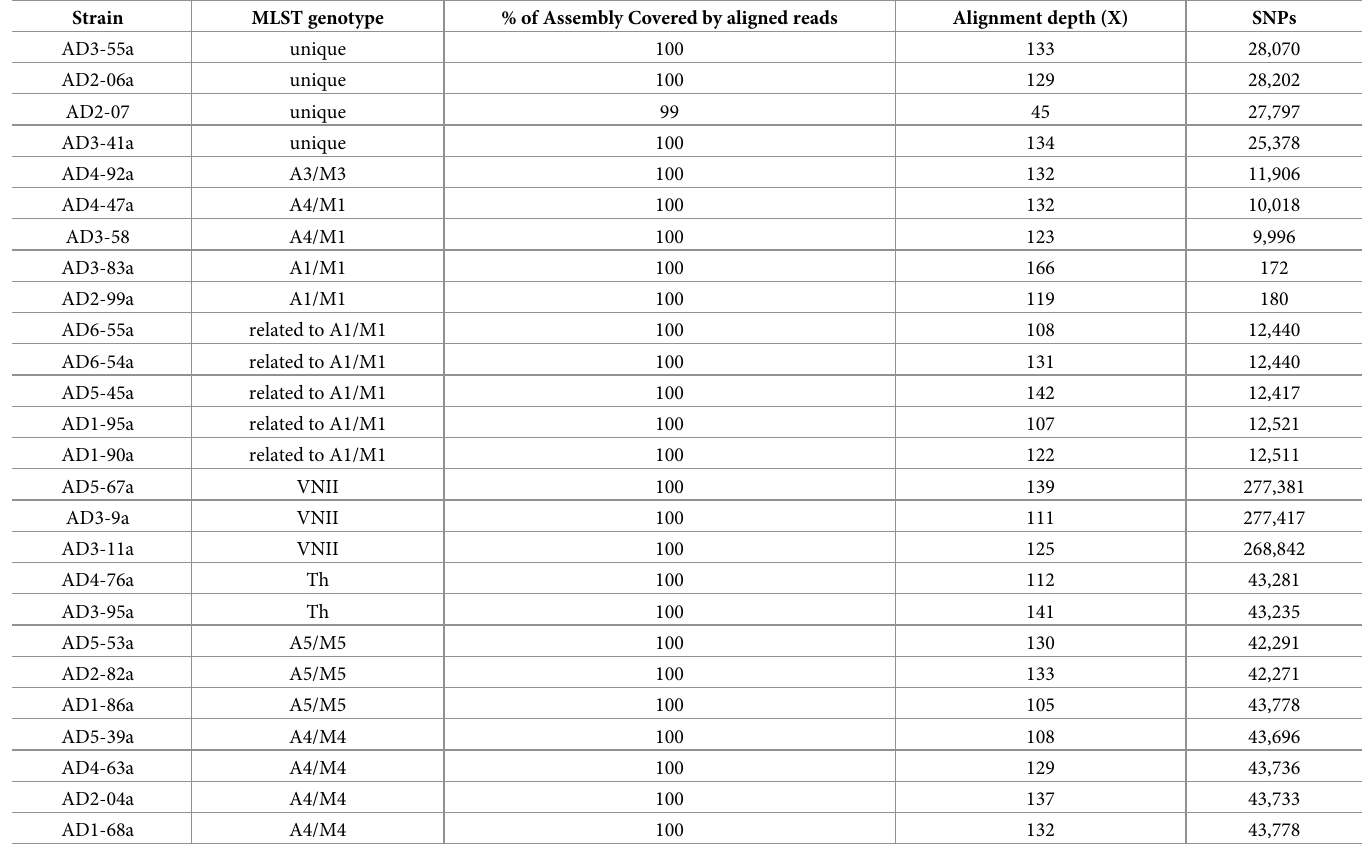
Table 2. Alignment and SNP statistics of sequenced isolates using H99 as a reference. Strain MLST genotype % of Assembly Covered by aligned reads Alignment depth (X) SNPs AD3-55a unique